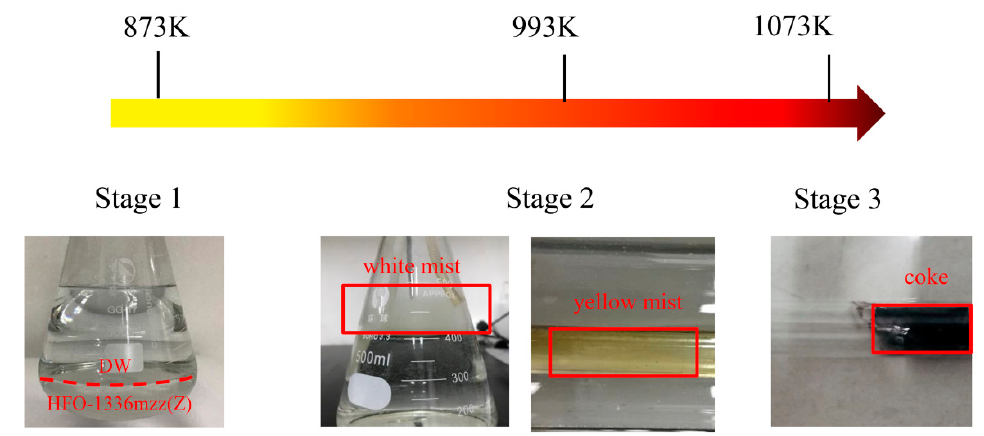
Figure 1. Crucial thermal decomposition temperature and phenomenon.